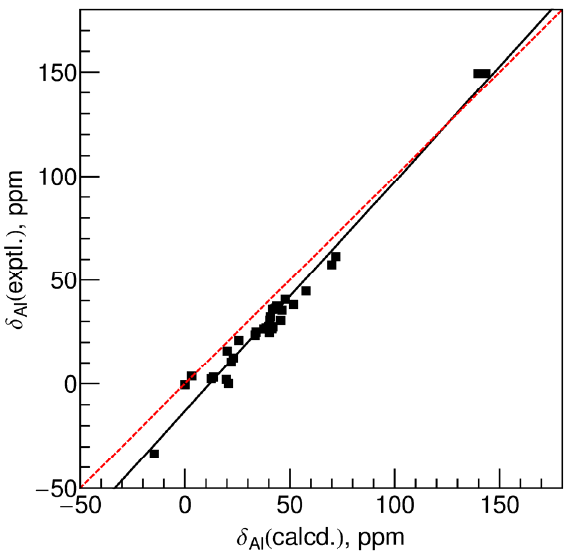
Figure 4. Correlation between the experimental 27 Al chemical shifts versus the calculated values at the GIAO-B3LYP/6-31G(d) level using the optimized geometries at the B3LYP/6-31G(d) level. The black solid line is the best-fit linear regression of the data and the best-fit equation is given in Equation 6, while the dashed red line is the ideal diagonal line ( y = x